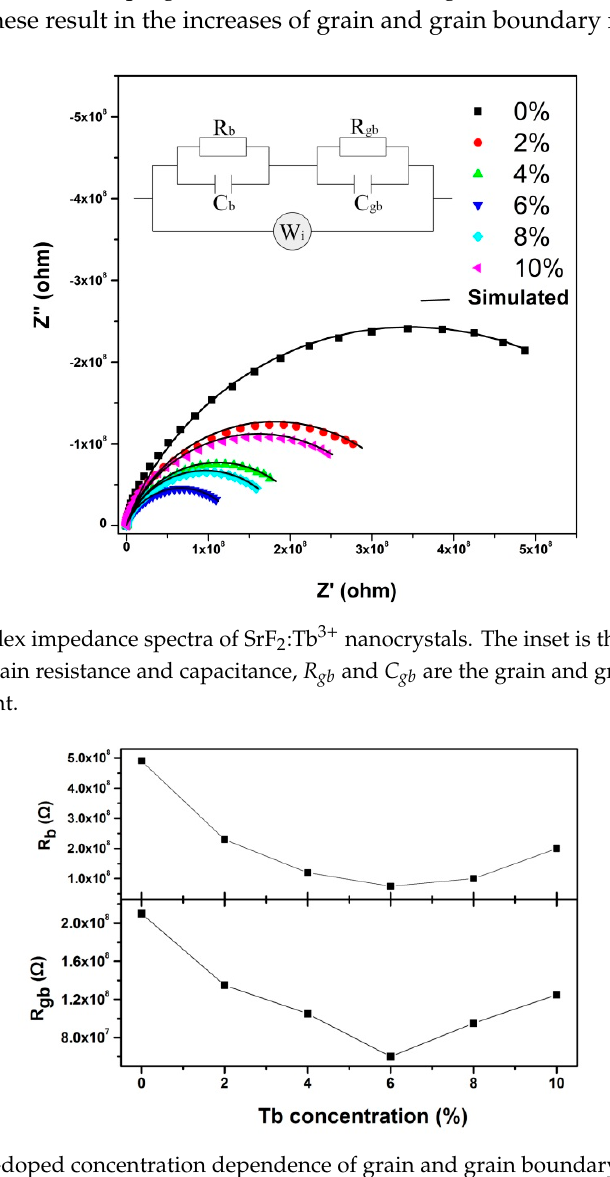
Figure 5. Tb-doped concentration dependence of grain and grain boundary resistances.